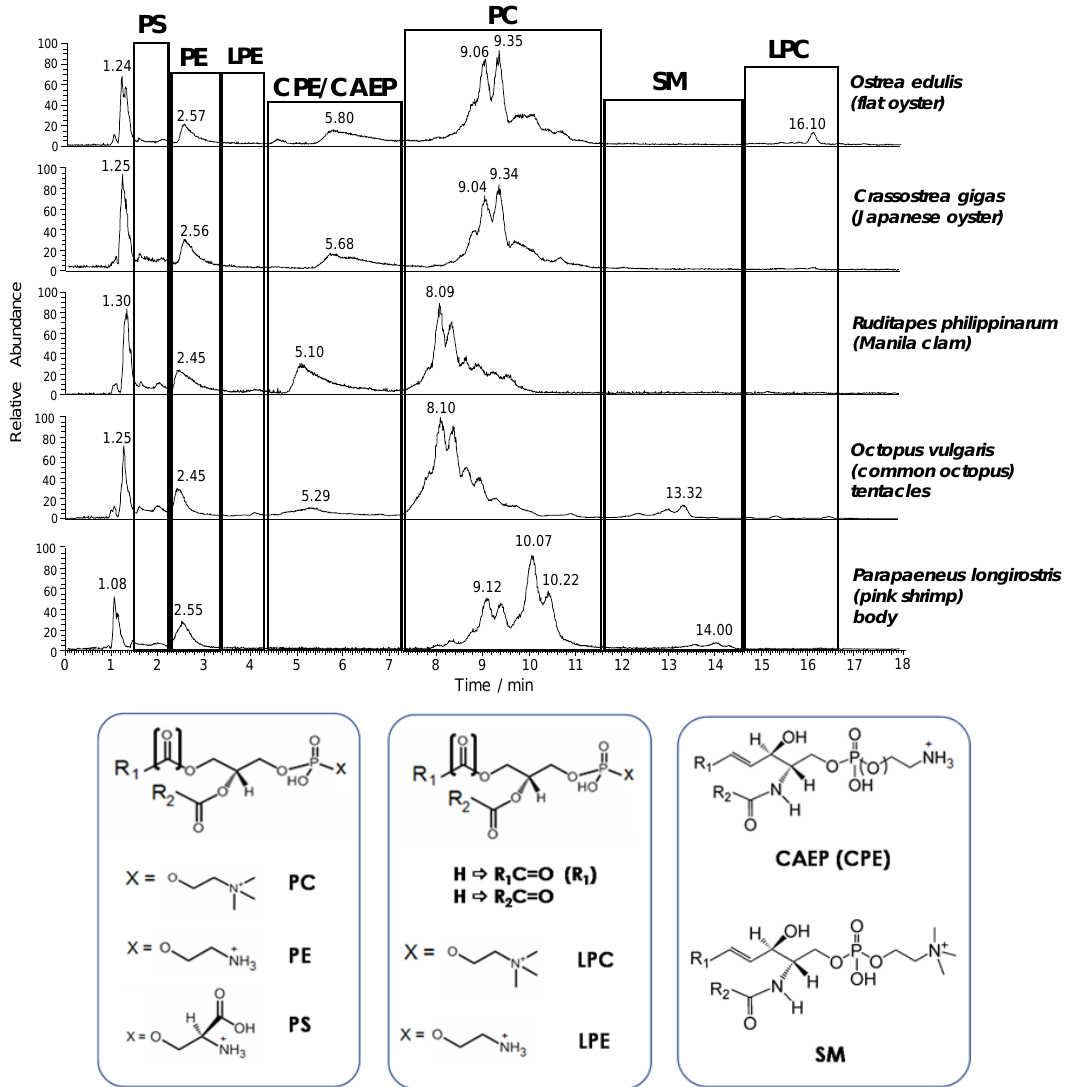
Figure 1. Comparison between hydrophilic interaction liquid chromatography–electrospray ionization(+)-Fourier transform mass spectrometry (HILIC–ESI(+)-FTMS) total ion current (TIC) chromatograms obtained for the lipid extracts of different seafood products, which were all purchased as fresh products and analyzed without further thermal treatments. The general structures of positive ions related to species belonging to the detected phospholipid (PL) classes are reported, with R 1 and R 2 representing saturated or unsaturated alkyl chains.